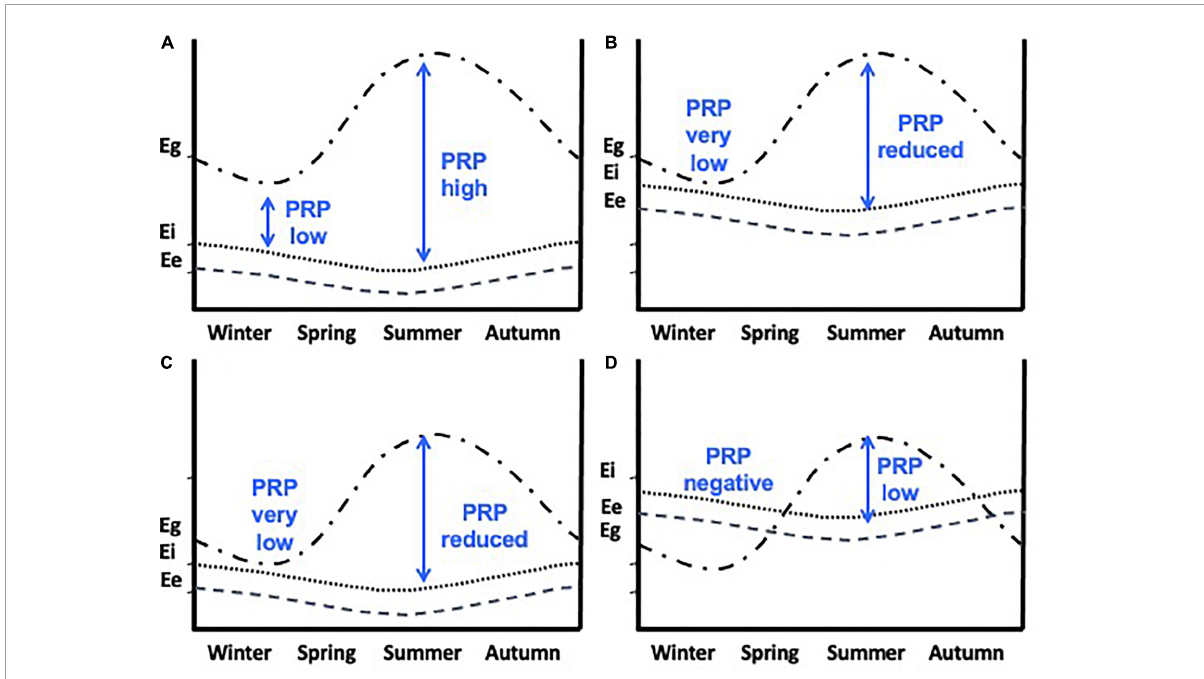
FIGURE3 Perturbation resistance potential (PRP) in different seasons. E g (also called E cr – cumulative resources) is the cumulative energetic resources available to an individual. E e represents the existence energy and E i is the additional energy required to go about daily routines. PRP, E g - E e + E i (vertical blue arrows). (A) PRP is higher in summer allowing more energetically demanding life-history stages such as breeding, molt and migrations to occur. (B) E e + E i are higher and because E g remains unchanged then PRP is very low in winter and reduced in spring and summer. (C) E e + E i remain the same as in (a) but E g is greatly reduced resulting in very low PRP. The worst-case scenario is shown in (D) where E e + E i are increased and E g is reduced. Now PRP is negative in winter and greatly reduced in spring and summer. When PRP is low then extreme climatic events could result in allostatic overload type 1. From Wingfield et al. (2017). Courtesy of the Royal Society,